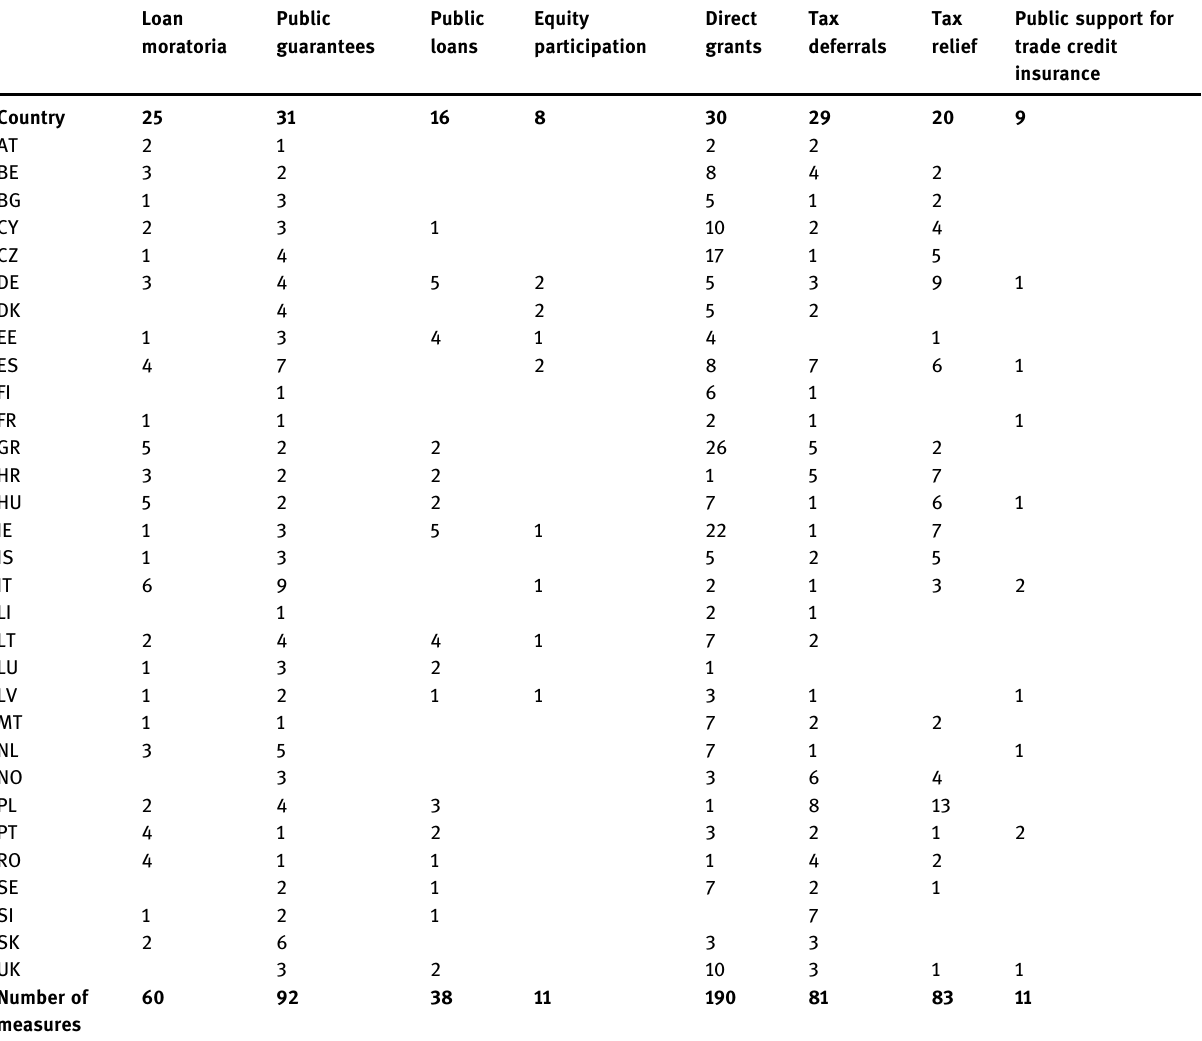
Table 1: Types of fi scal - budgetary measures